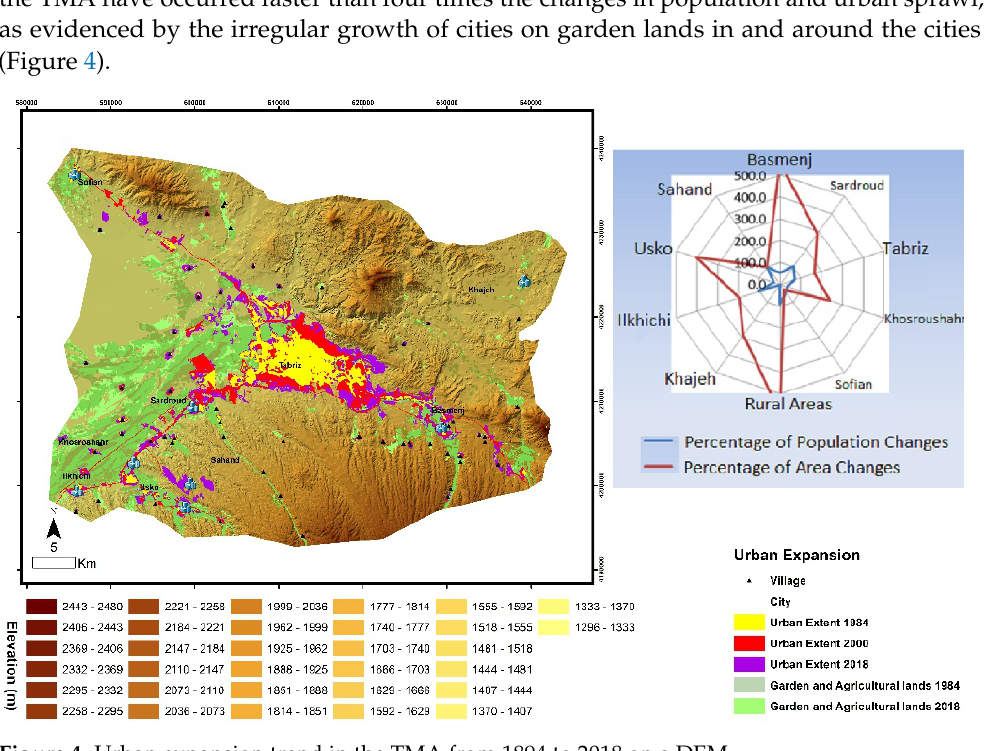
Figure 4. Urban expansion trend in the TMA from 1894 to 2018 on a DEM.